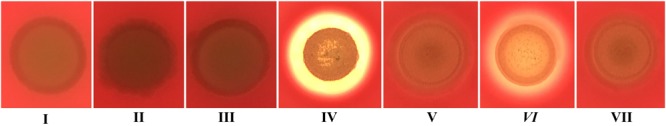
Hemolytic activity of different Vibrio cholerae strains on LB-5% sheep blood agar. After being incubated at 37°C for 48 h, the LB blood plates were photographed. I, II, III, IV, V, VI, and VII represent WT/pBAD24, ΔhlyU/pBAD24, ΔhlyU/pBAD24-hlyU, ΔhapR/pBAD24, ΔhapR/pBAD24-hapR, Δfur/pBAD24, and Δfur/pBAD24-fur, respectively.